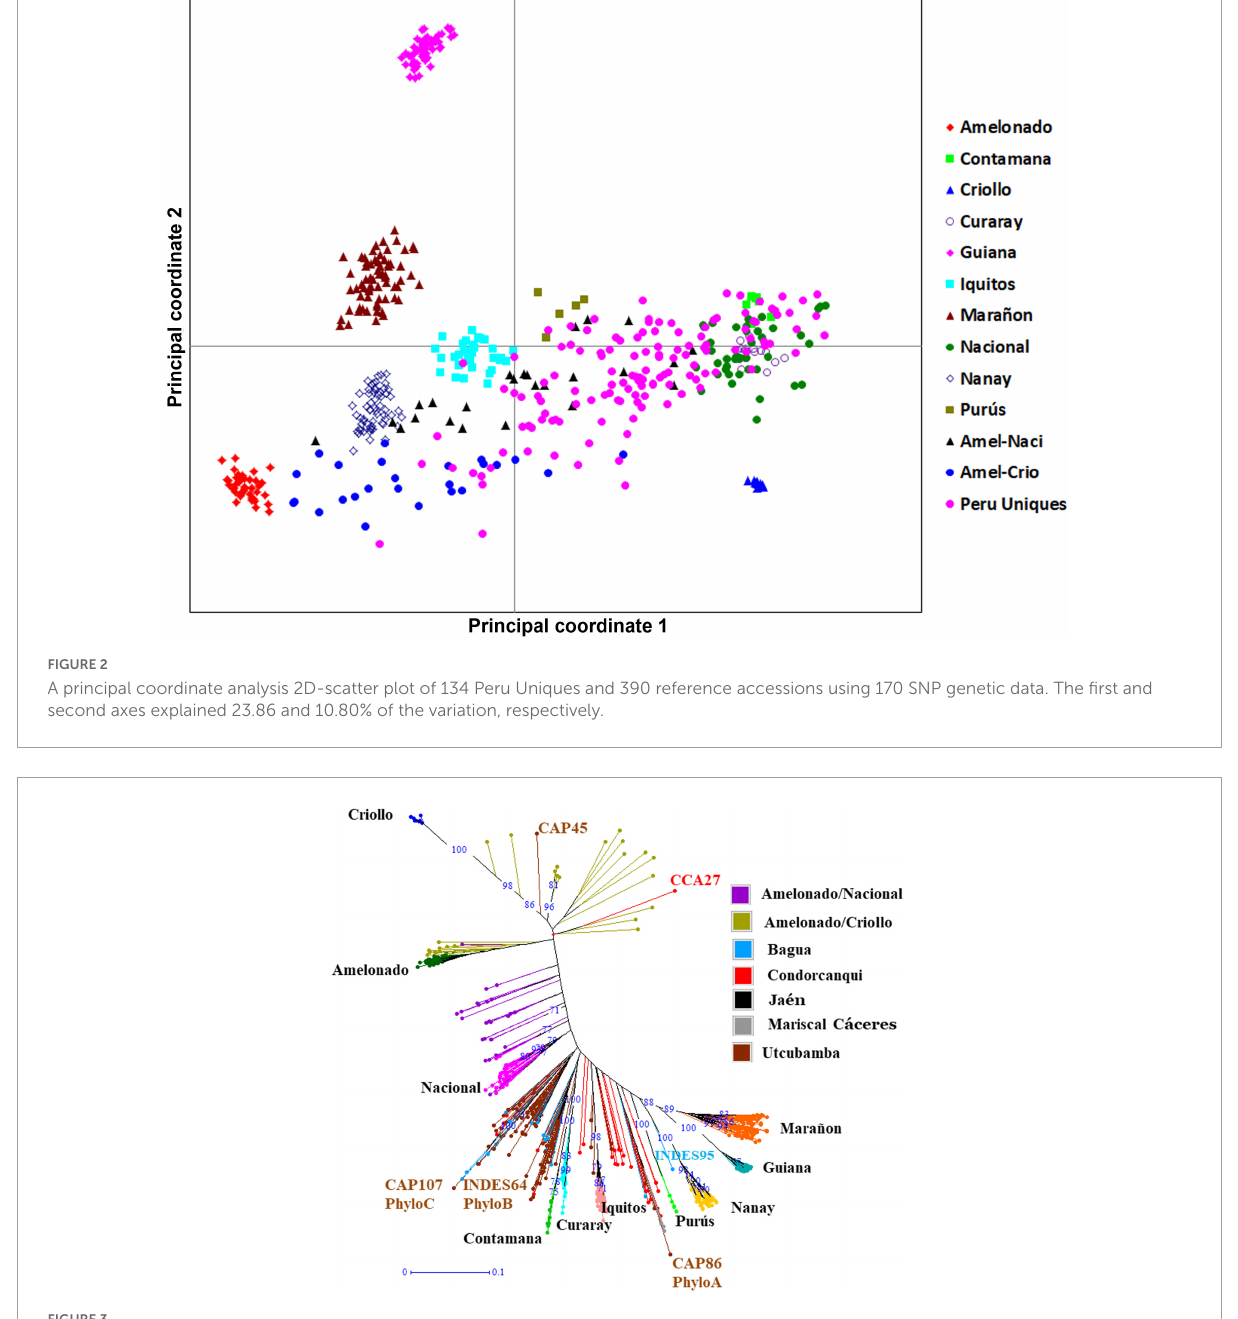
Utcubamba ( D est = 0.016; P = 0.006) but Bagua vs. Utcubamba was low and non-significant ( D est = 0.001; P = 0.285). Phylogenetic clusters of the 10 population groups of Motamayor